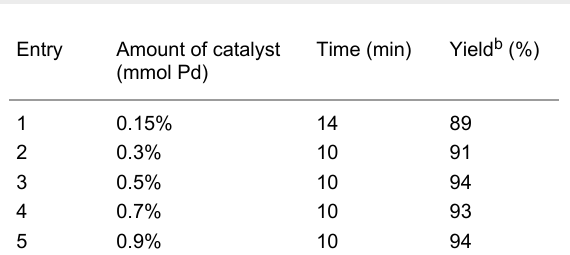
Table 1: Effect of base on the Suzuki–Miyaura cross-coupling reac- tion a .